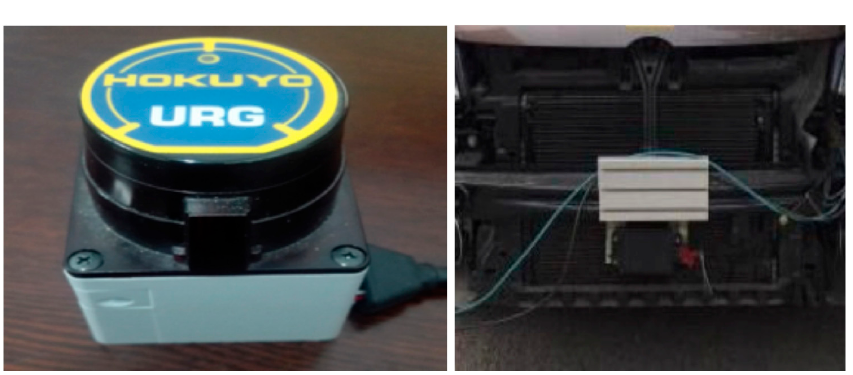
Table 2. Parameters of URG and ESR.